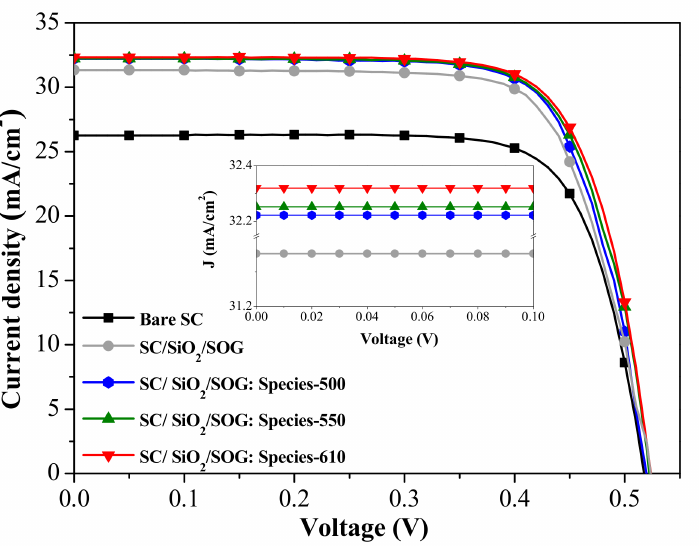
Figure 10. Photovoltaic J-V curves of bare silicon solar cell, cell with spacer/SOG, and cells with spacer/SOG-phosphors (species-500, species-550, and